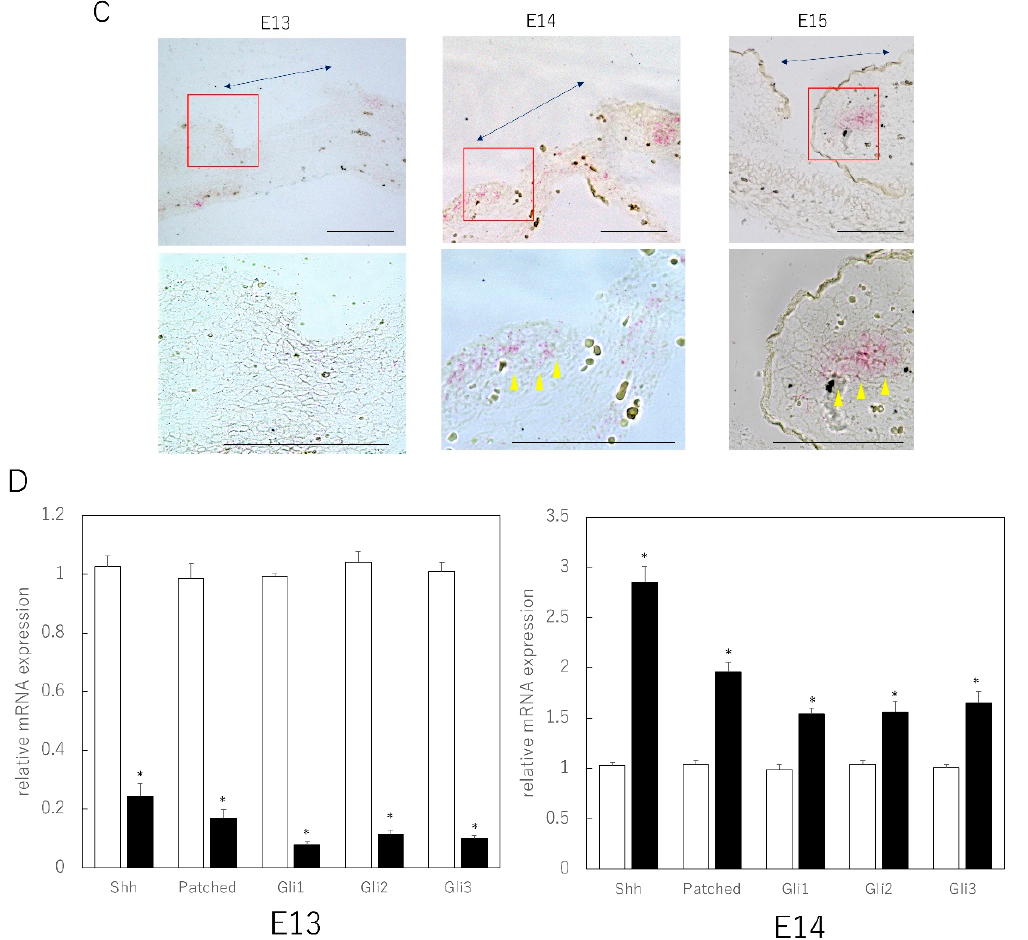
Figure 1. Expression of Shh during wound healing in mice. ( A ) Immunostaining analysis of Shh expression during wound healing in adult mice. The yellow arrows indicate the extent of the wound. Bar = 200 μ m. To compare Shh expression, we quantified the average fluorescence intensity in at least 10 areas within the wound, in sections 10 μ m 2 . ( B ) Immunostaining analysis of Shh expression during wound healing in fetal mice. Yellow arrows indicate the extent of the wound; Bar = 100 μ m. To compare Shh expression, we quantified the average fluorescence intensity in at least 10 areas within the wound, in sections 10 μ m 2 . ( C ) In situ hybridization analysis of the expression of Shh 24 h after fetal mouse wounding. The black arrows indicate the extent of the wound. The tip of the wound, circled with a red square, is magnified in the bottom row. The blue arrows indicate the area of the wound. Yellow arrows indicate the expression of Shh in the dermis. Bar = 100 μ m. ( D ) Expression of Shh signaling-related genes in E13 and E14. The expression of Shh and all the signaling molecules involved in Shh signaling was decreased in E13 mouse wounds compared to normal skin, whereas the expression of Shh and the signaling molecules downstream of patched1 increased in wounds in E14. * p <